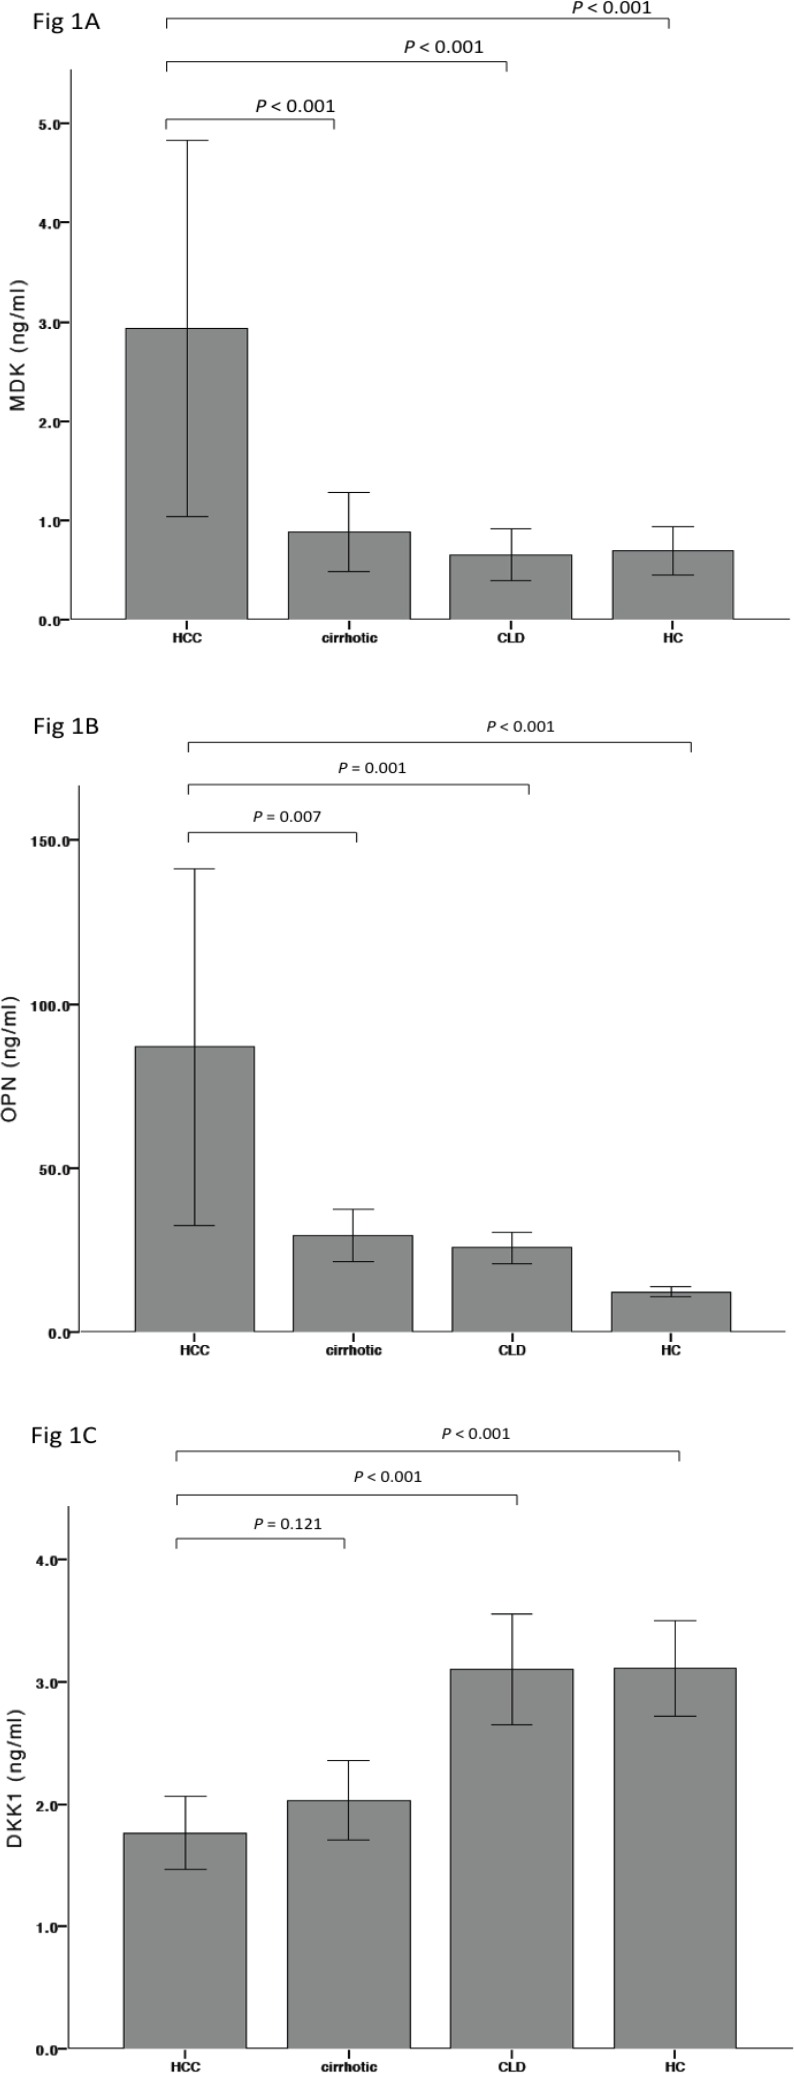
Mean serum MDK, OPN and DKK1 concentrations in HCC and control groups.A–C) MDK, OPN and DKK1 levels respectively for HCC and control groups. Mean values and 95% confidence intervals are shown. Abbreviations: MDK, midkine; OPN, osteopontin; DKK1, dickopff-1; HCC, hepatocellular carcinoma; CLD, chronic liver disease; HC, healthy controls. Comparison between HCC and the control groups was performed by independent variable t tests after log transformation of non-parametric data.